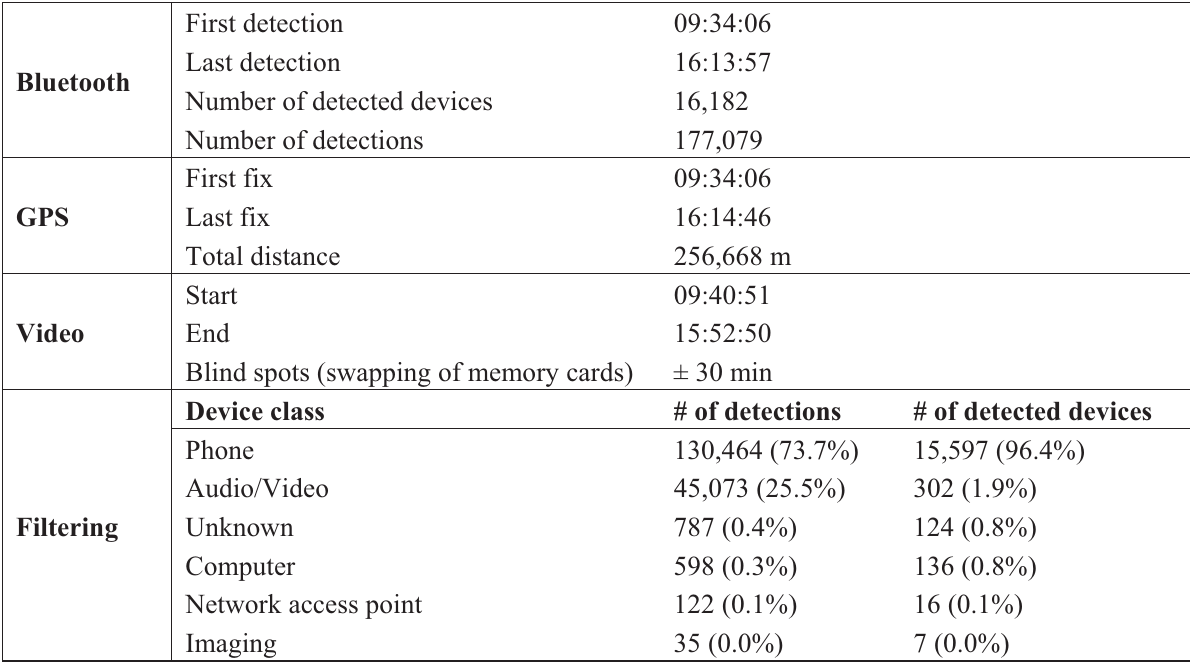
Table 2. Data pre-processing